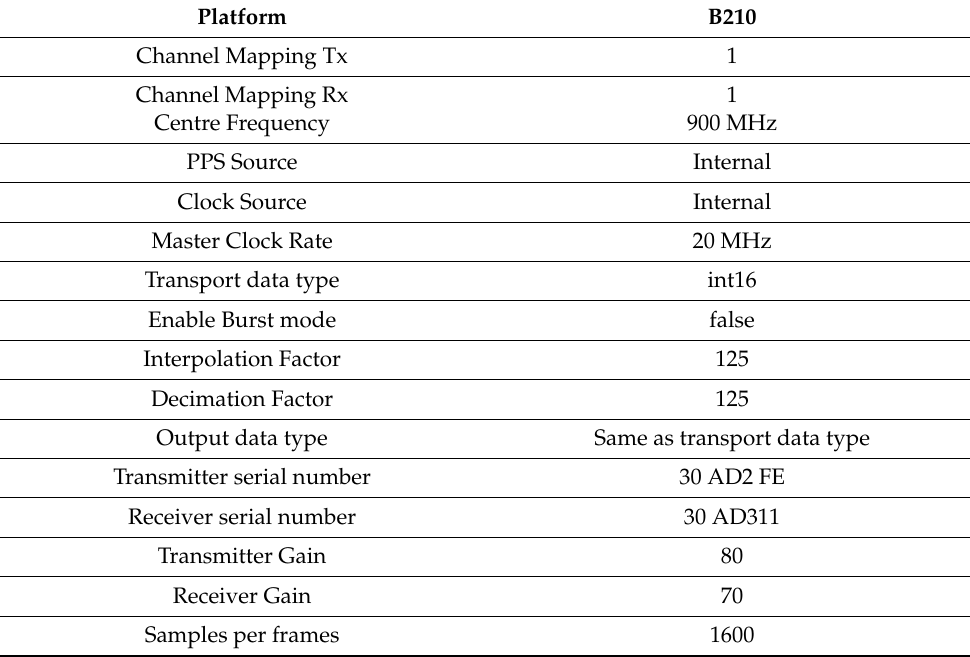
Figure 4. Experimental setup for breathing experiments in the lab environment. Table 2. Hardware configurations for breathing experiments.